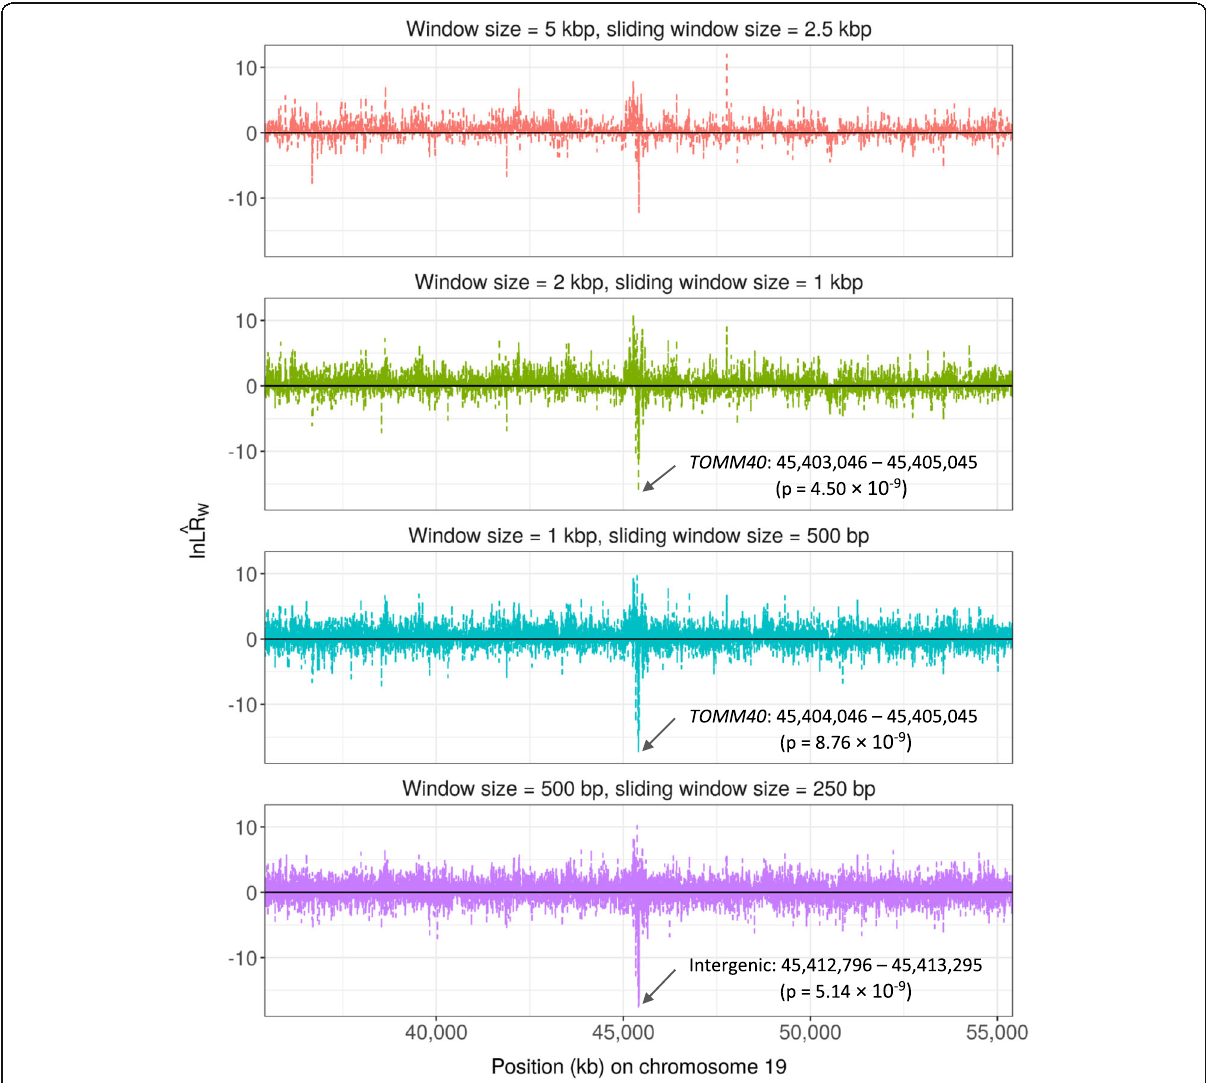
Fig. 3 Plots of ln b LR W for the associations between rare variants around APOE (± 10 M bp) located on chromosome 19 and log-transformed CSF amyloid β 1 – 42 levels in ADNI. Positive ln b LR W represents test statistics for ^ μ W